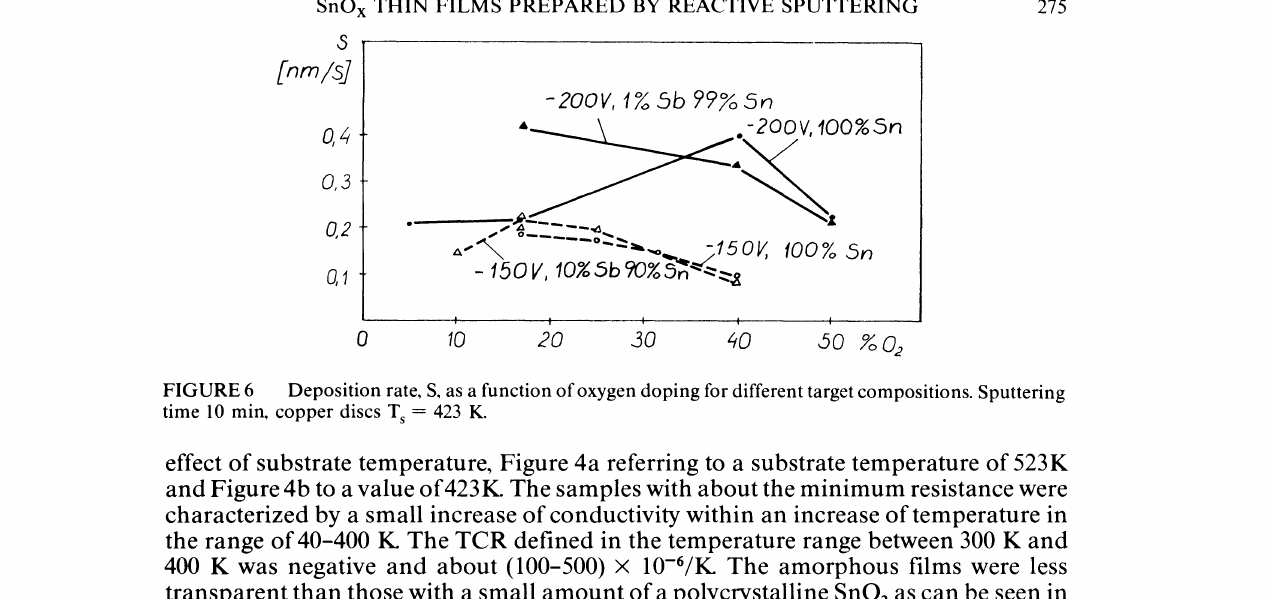
FIGURE 6 Deposition rate, S, as a function of oxygen doping for different target compositions. Sputtering time 10 min, copper discs T 423 K.